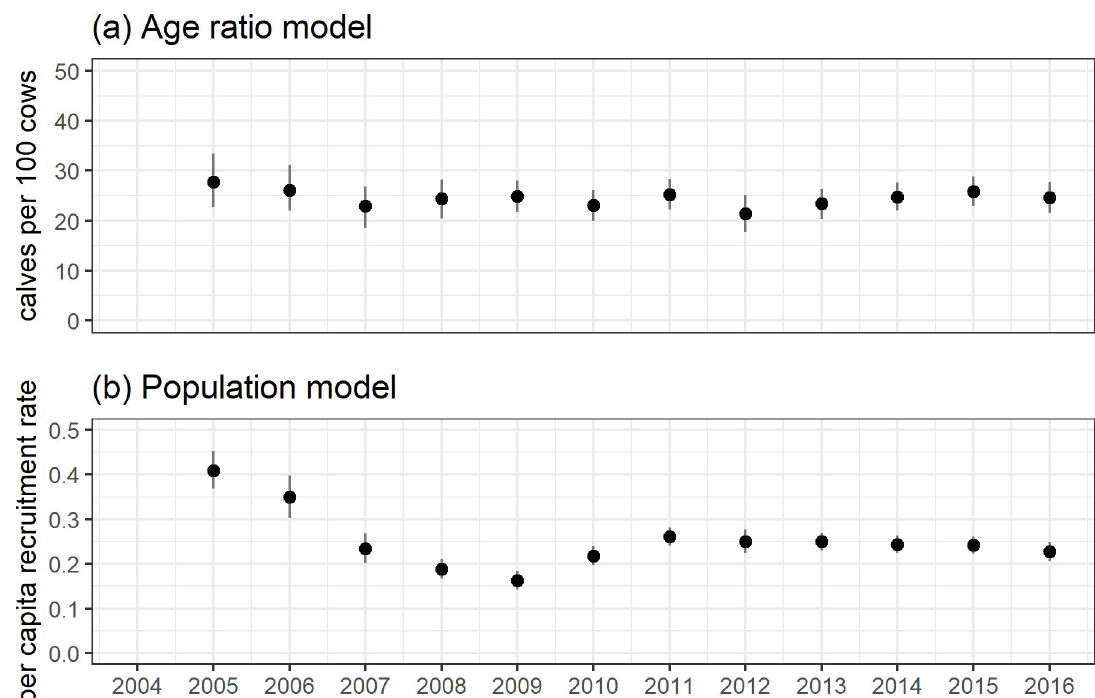
Fig 5. Estimated average values among years for (a) age ratios, and (b) per capita recruitment rates. These values were calculated by generating an approximate posterior distribution for the average value (age ratio or rate) across hunting districts within a year. The black dot denotes the median of the approximate posterior distribution, the heavy black line the 50% highest posterior density interval (HPD) and the light black line the 90% HPD